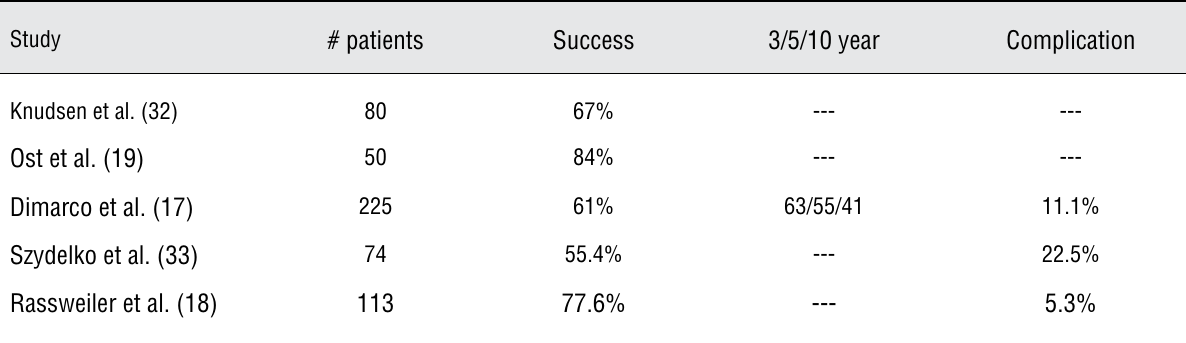
Table 5 - Endopyelotomy